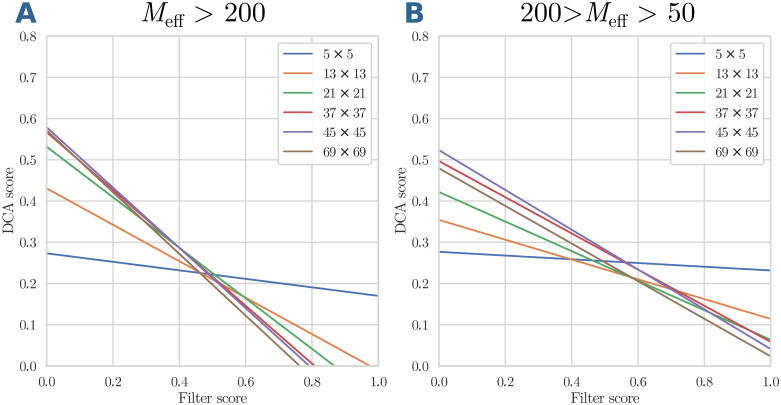
Decision boundary for logistic regression.The lines show, for large (panel A) and medium (panel B) MSA sizes, the decision boundary defined by P(⊕|x) = 1/2, for different filter sizes raging from 5 × 5 to 69 × 69.